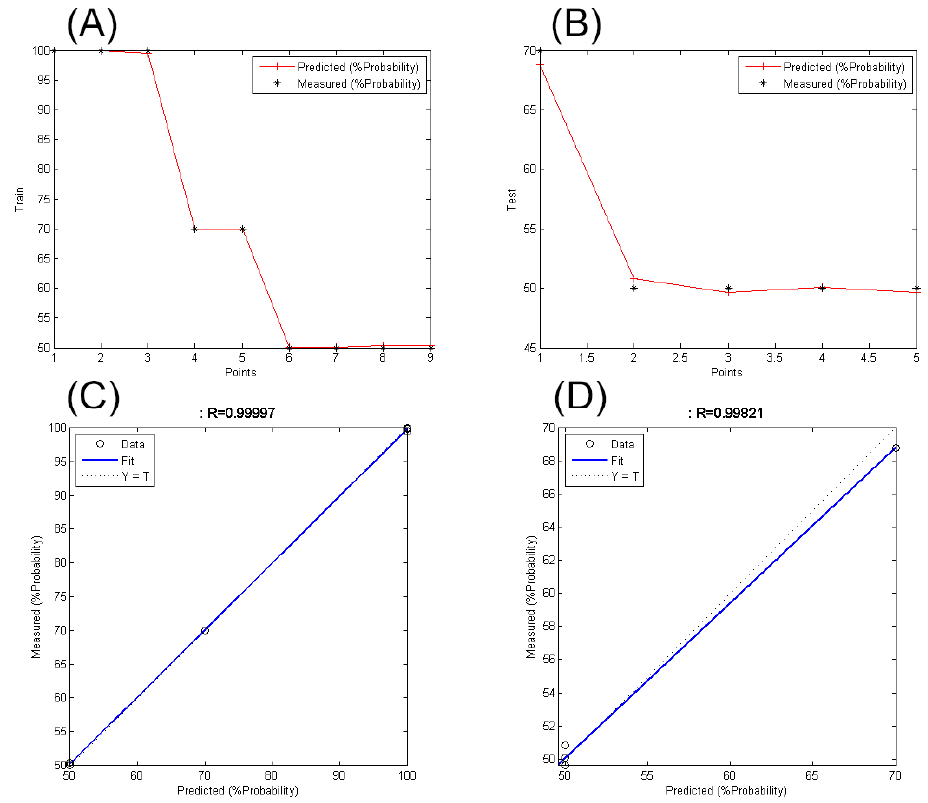
Figure 11. ( A ) Copper occurrences estimation line based on copper occurrences in training data; ( B ) copper occurrences estimation line based on copper occurrences in test data; ( C ) regression of estimated data versus training data; ( D ) regression of estimated data versus test data.